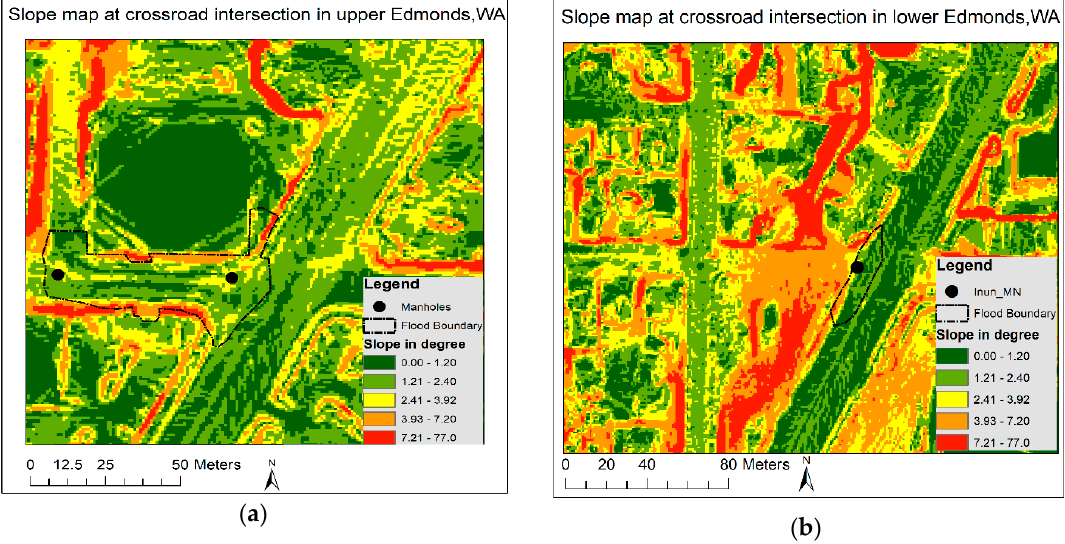
Figure 11. Slope map of the two-flooded regions considered in our study. Case 1 ( a ) and Case 2 ( b ).